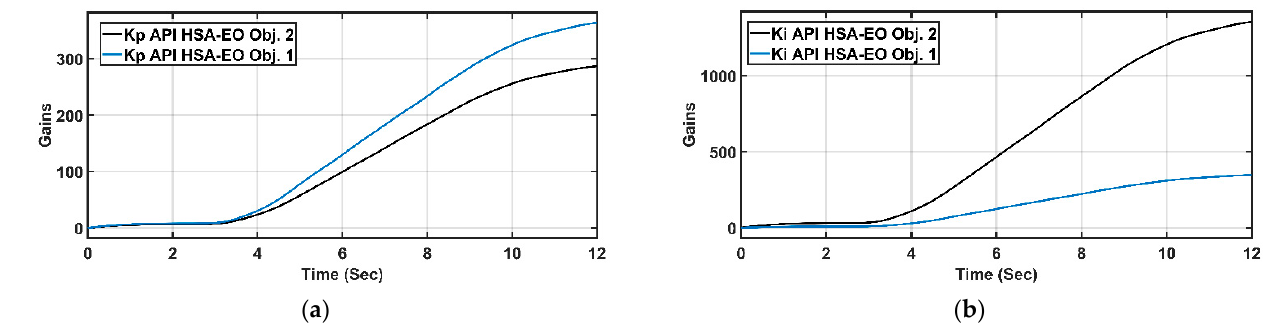
Figure 36. ( a ) (cid:1837) (cid:3043) adaptive PI gain of faulty third case. ( b ) (cid:1837) (cid:3036) adaptive PI gain of faulty third case. Figure 36. ( a ) K p adaptive PI gain of faulty third case. ( b ) K i adaptive PI gain of faulty third case. The numerical comparisons of the controllers are listed in Table 17. The settling time,